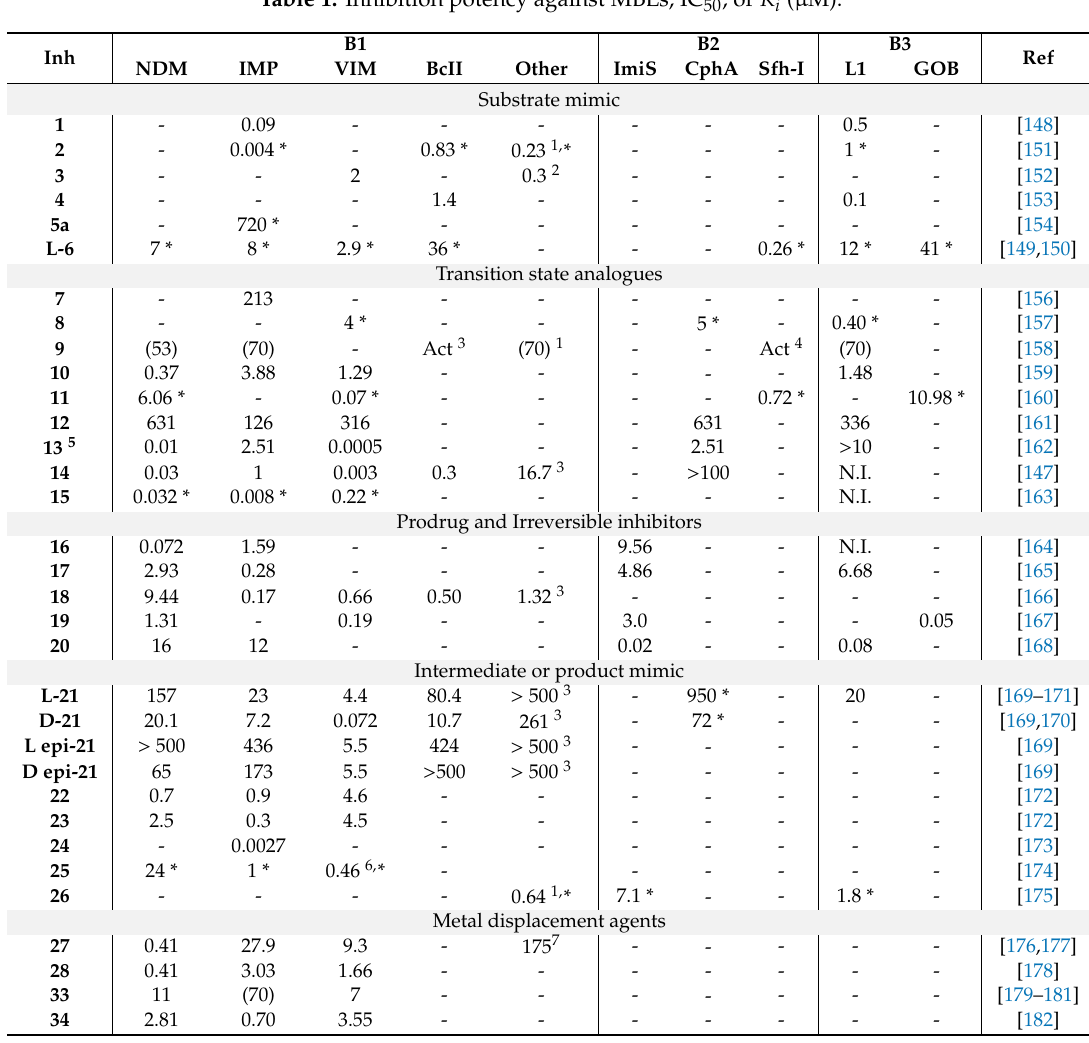
Figure 5. MBL substrate mimic inhibitors. Table 1. Inhibition potency against MBLs, IC 50 , or K i ( µ